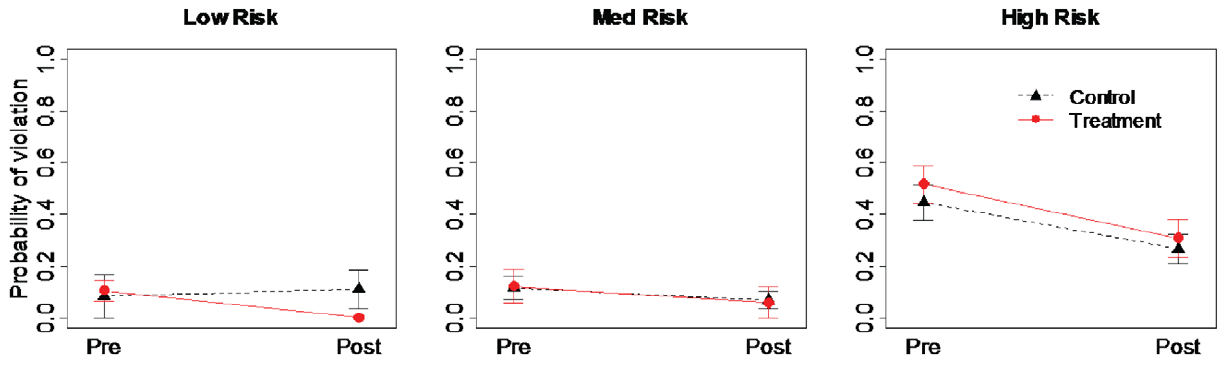
Figure 3. Results of on-site education experiment for communal housing complexes. Differences in mean ( 6 1 SE) probability of violation between pre- (Pre), and post-treatment (Post) periods for dumpsters of low, medium, and high risk to break-in by bears for a 2007 experiment testing the efficacy of an on-site education sign as a management tool in reducing availability of garbage to bears in Aspen, Colorado, USA. Note: probability of violation was zero for all treatment low risk dumpsters in the post-treatment period; hence no error